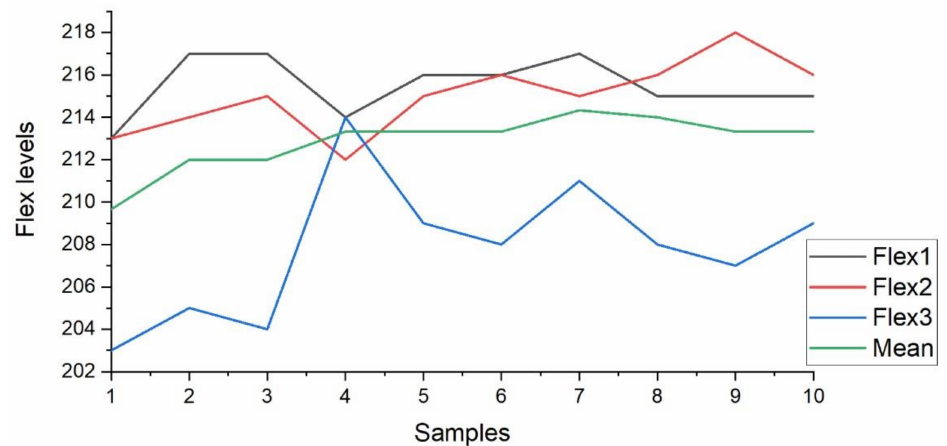
Figure 12. Value variations for samples in Feb